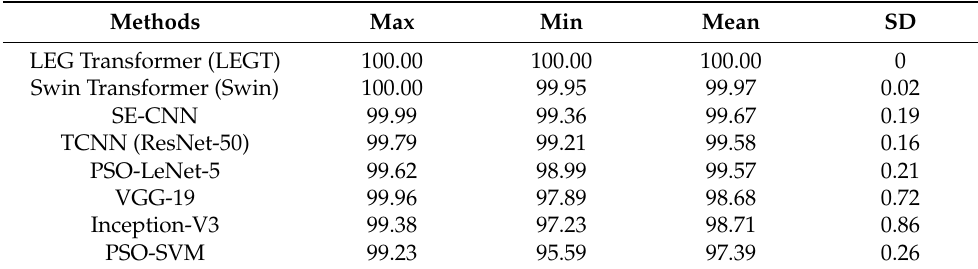
Table 6. Comparative results published in the literature.